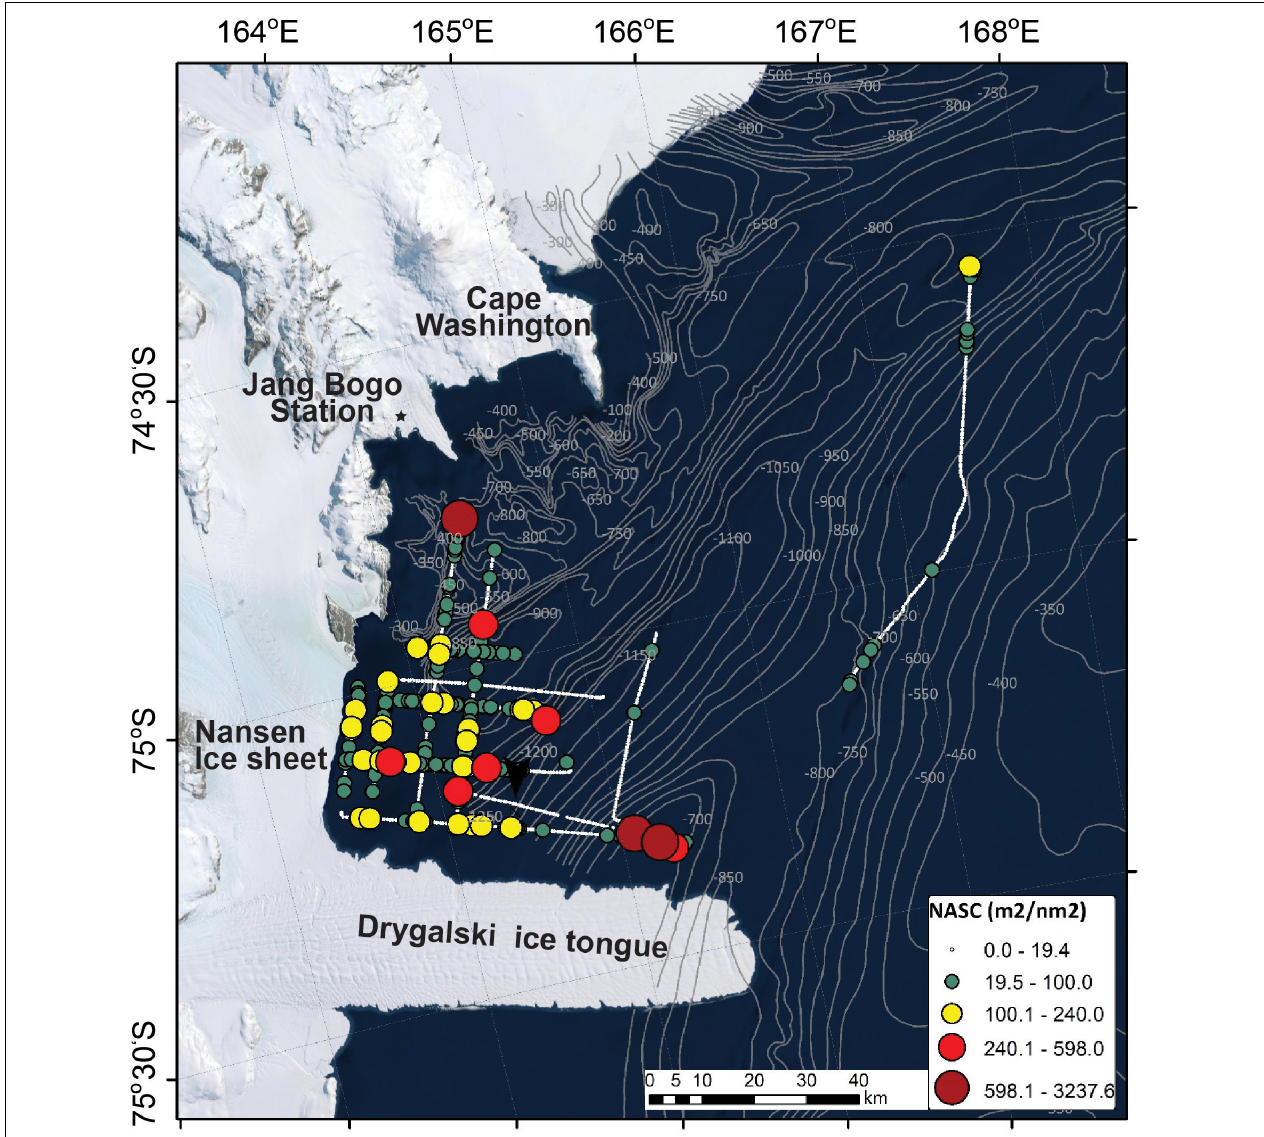
FIGURE 4 | The horizontal distribution of krill NASC values, which were integral of Sv values from 10 m to 300 m, on 7–14 January